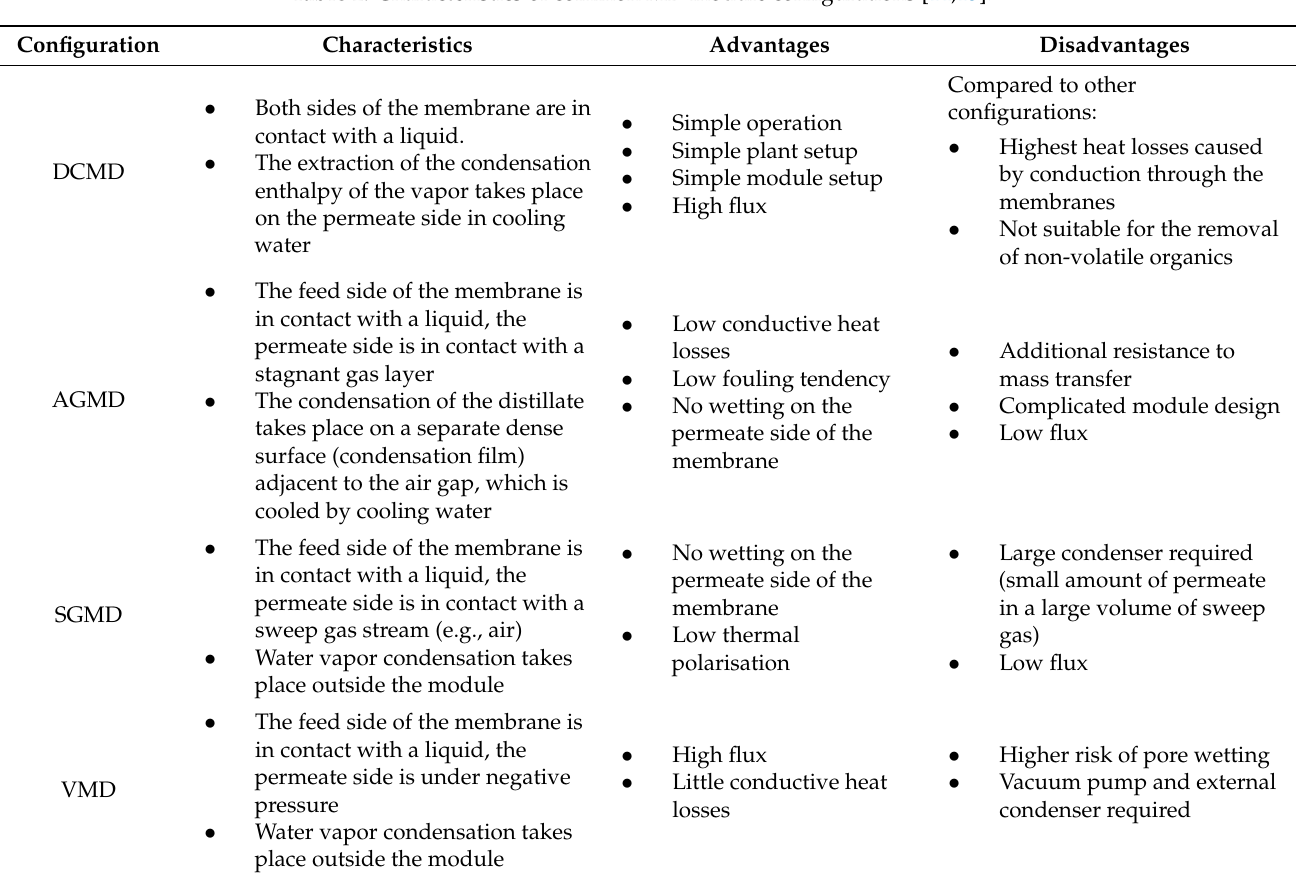
Table 2. Characteristics of common MD module configurations